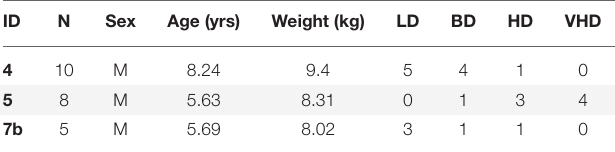
Age and Weight values represent cohort averages. Each cohort is further subdivided into four drinking categories: LD, light drinkers; BD, binge drinkers; HD, heavy drinkers; and VHD, very heavy